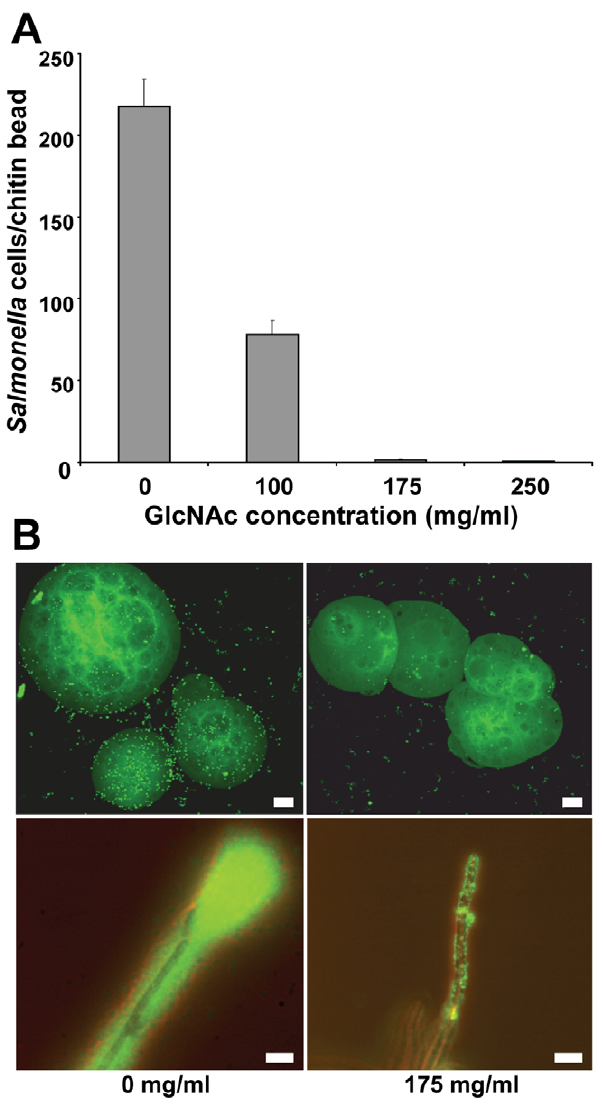
Figure 2. Inhibitory effect of pre-incubation of S . Typhimurium with GlcNAc on its attachment to chitin beads and A. niger hyphae. (A) Increasing concentrations of GlcNAc greatly inhibited the number of bacterial cells attached per chitin bead; mean number of cells per bead was 0.30 (s.e.m., 0.13) with 250 mg/ml GlcNAc. (B) Epifluorescence microscopy of bacterial cells pre-treated with 175 mg/ ml GlcNAc revealed minimal binding to chitin beads (top right panel) and lack of biofilm formation on the hyphae (lower right panel), compared with the controls (left panels), as evidence by staining with SYTO 9 H . Scale bars, 20 m m.